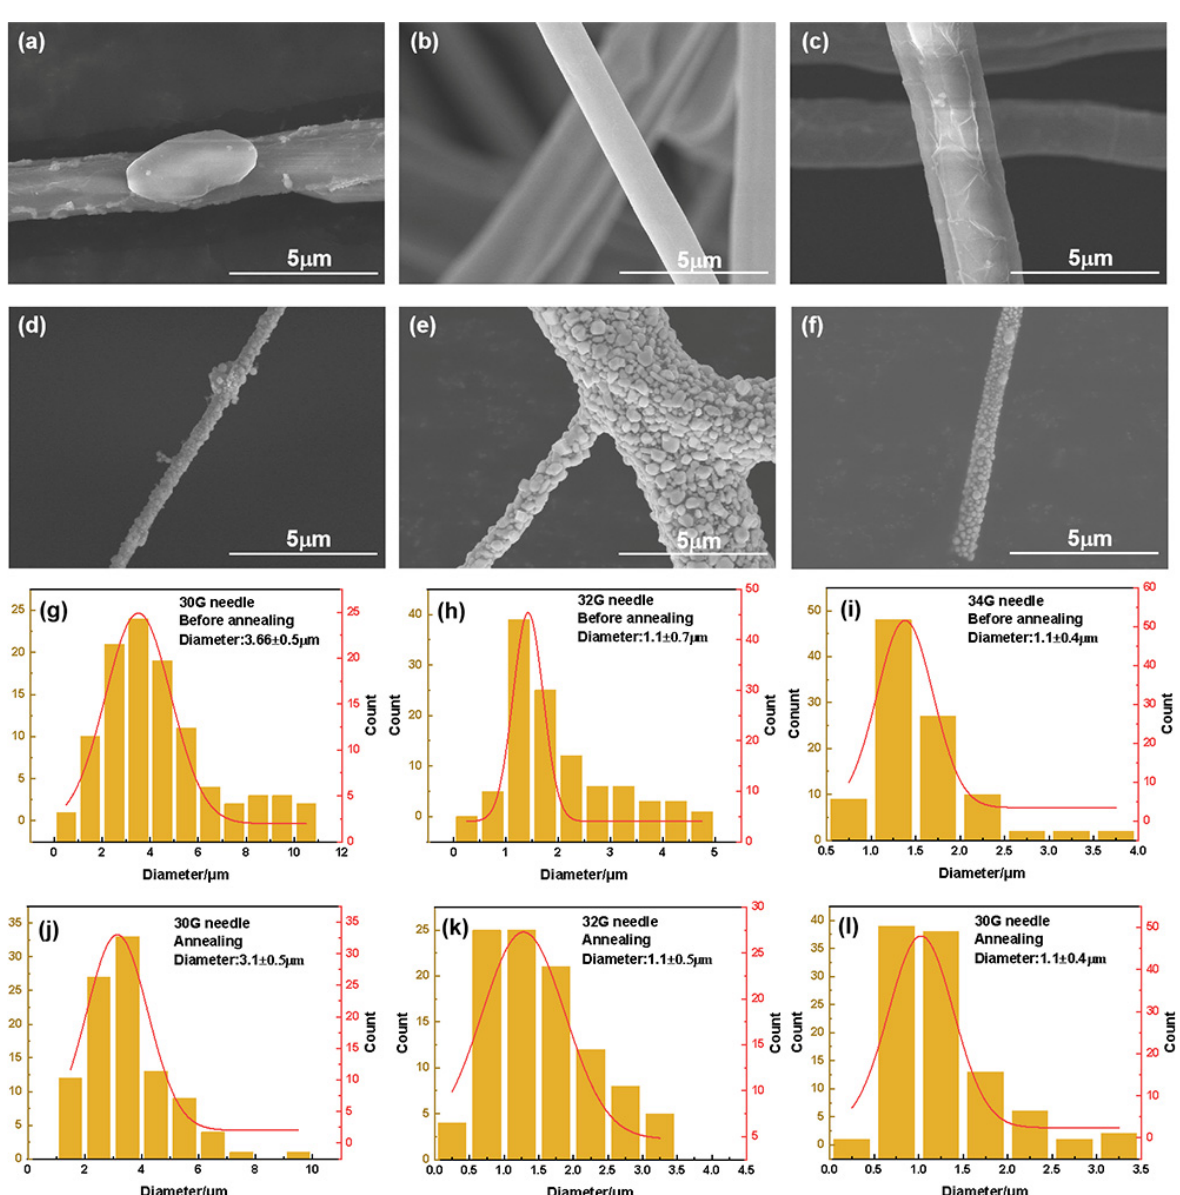
Figure 4. Characterization of centrifugally spun microfibers based on different needle sizes. SEM images of centrifugal-spun silver precursor fibers from needle sizes of 30G ( a ), 32G ( b ), and 34G ( c ). SEM images of annealed silver fibers from needle sizes of 30G ( d ), 32G ( e ), and 34G ( f ). Diameter distributions of centrifugal-spun silver precursor fibers from needle sizes of 30G ( g ), 32G ( h ), and 34G ( i ). Diameter distributions of annealed silver fibers from needle sizes of 30G ( j ), 32G ( k ), and 34G ( l ).